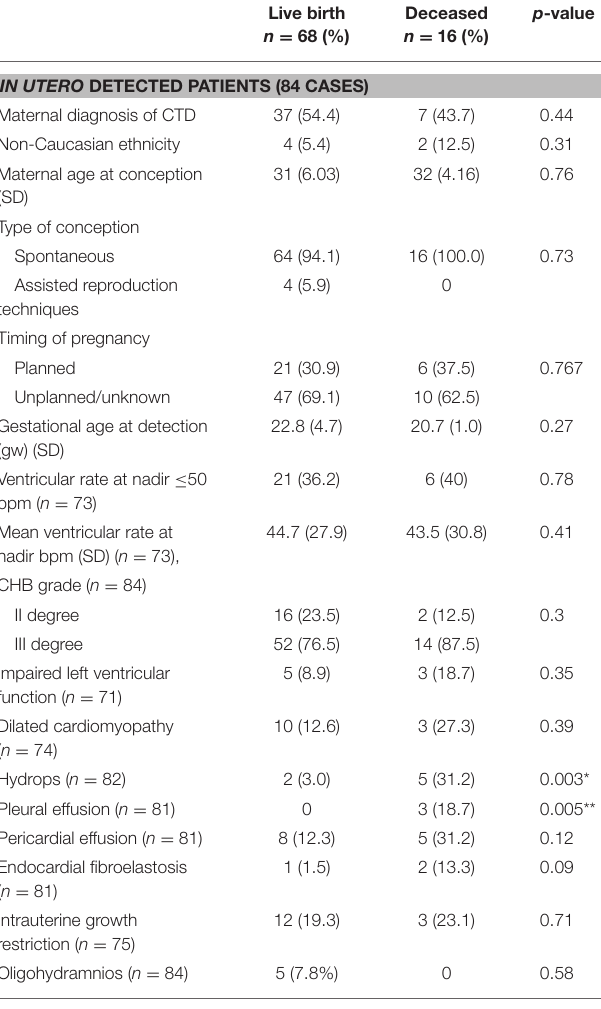
Live birth n = 73